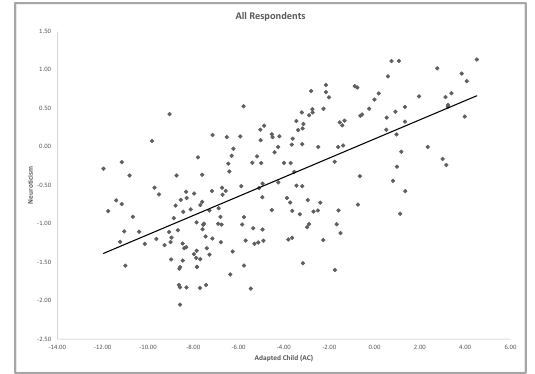
Figure 2. Moderately positive r between Critical Parent (CP) and Neuroticism.